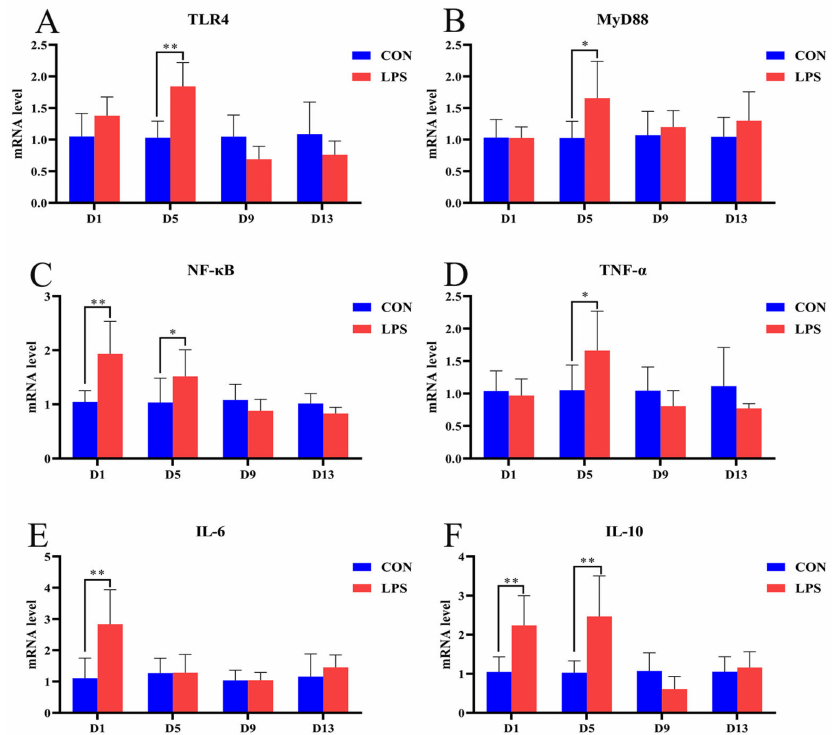
Figure 3. Effects of LPS induction on the TLR4/MyD88/NF- κ B signal and inflammatory cytokines in livers. Note: ( A ) TLR4, toll-like receptor 4; ( B ) MyD88, myeloid differentiation factor 88; ( C ) NF- κ B, nuclear factor- κ B; ( D ) TNF- α , tumor necrosis factor-alpha; ( E ) IL-6, interleukin-6; ( F ) IL-10, interleukin-10. Data represent the mean ± standard deviation (n = 6 in each group), “*” indicates a significant difference ( p < 0.05), and “**” indicates an extremely significant difference ( p <